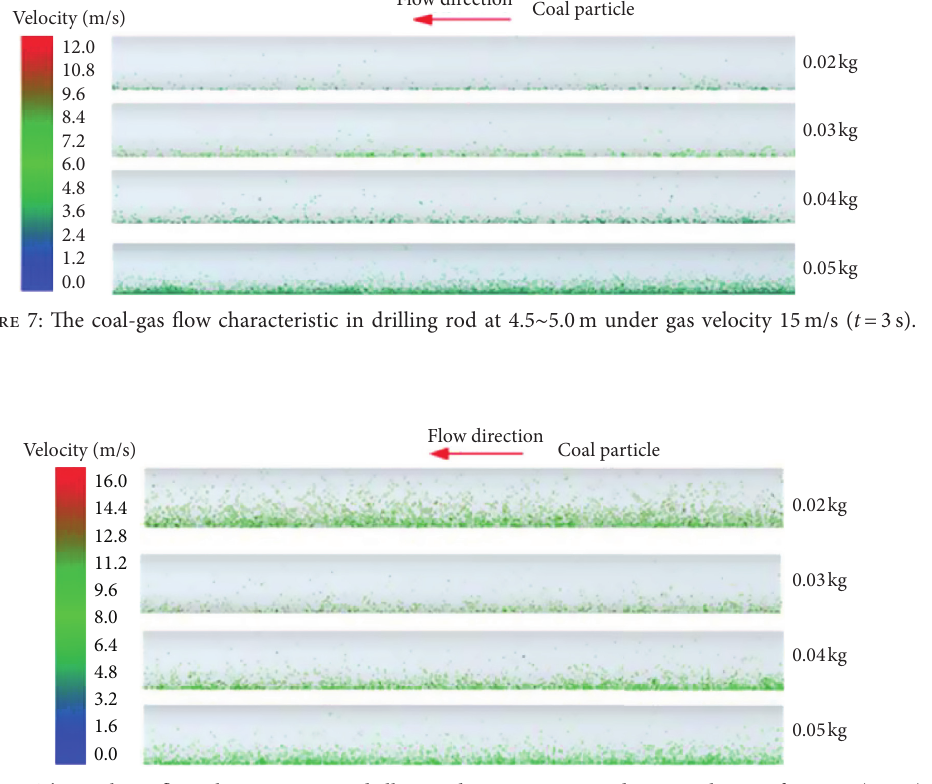
Figure 8: The coal-gas flow characteristic in drilling rod at 4.5 ∼ 5.0m under gas velocity of 20m/s ( t �